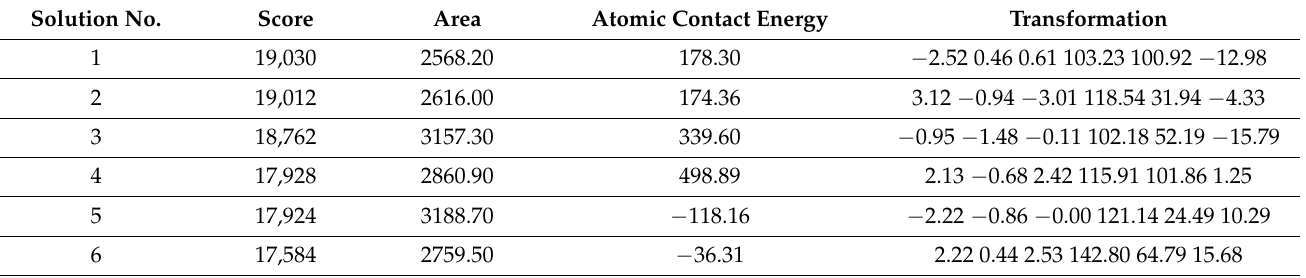
Table 9. Top 20 docking score of the vaccine and MHC-II, generated by the PATCHDOCK webserver. Solution